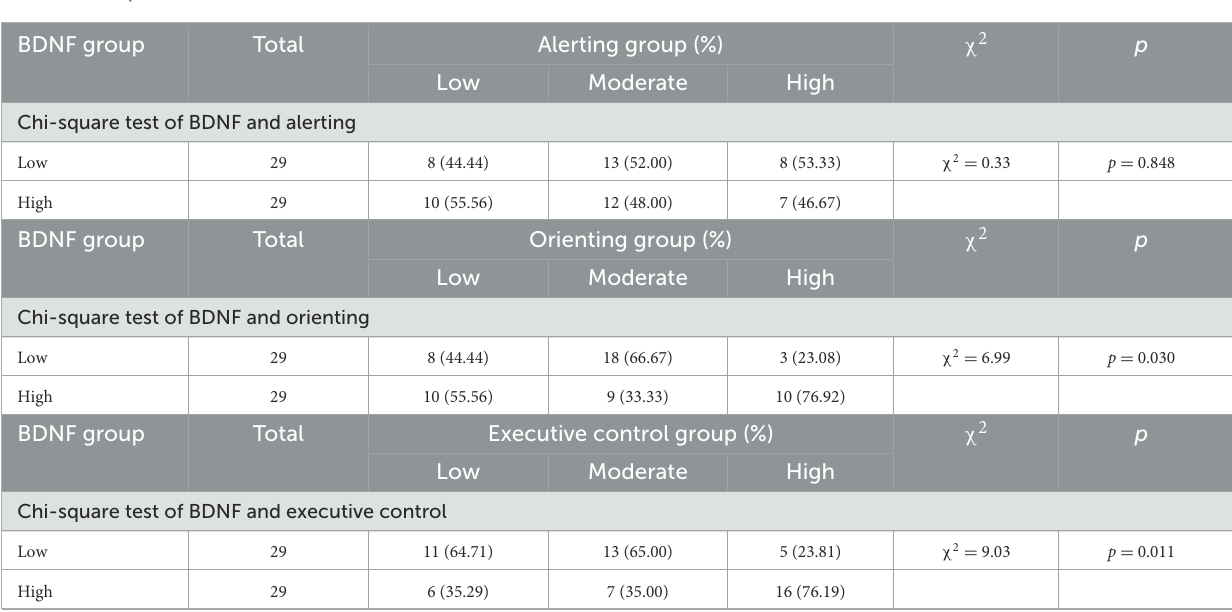
TABLE 3 Chi-square test of BDNF and three attentional